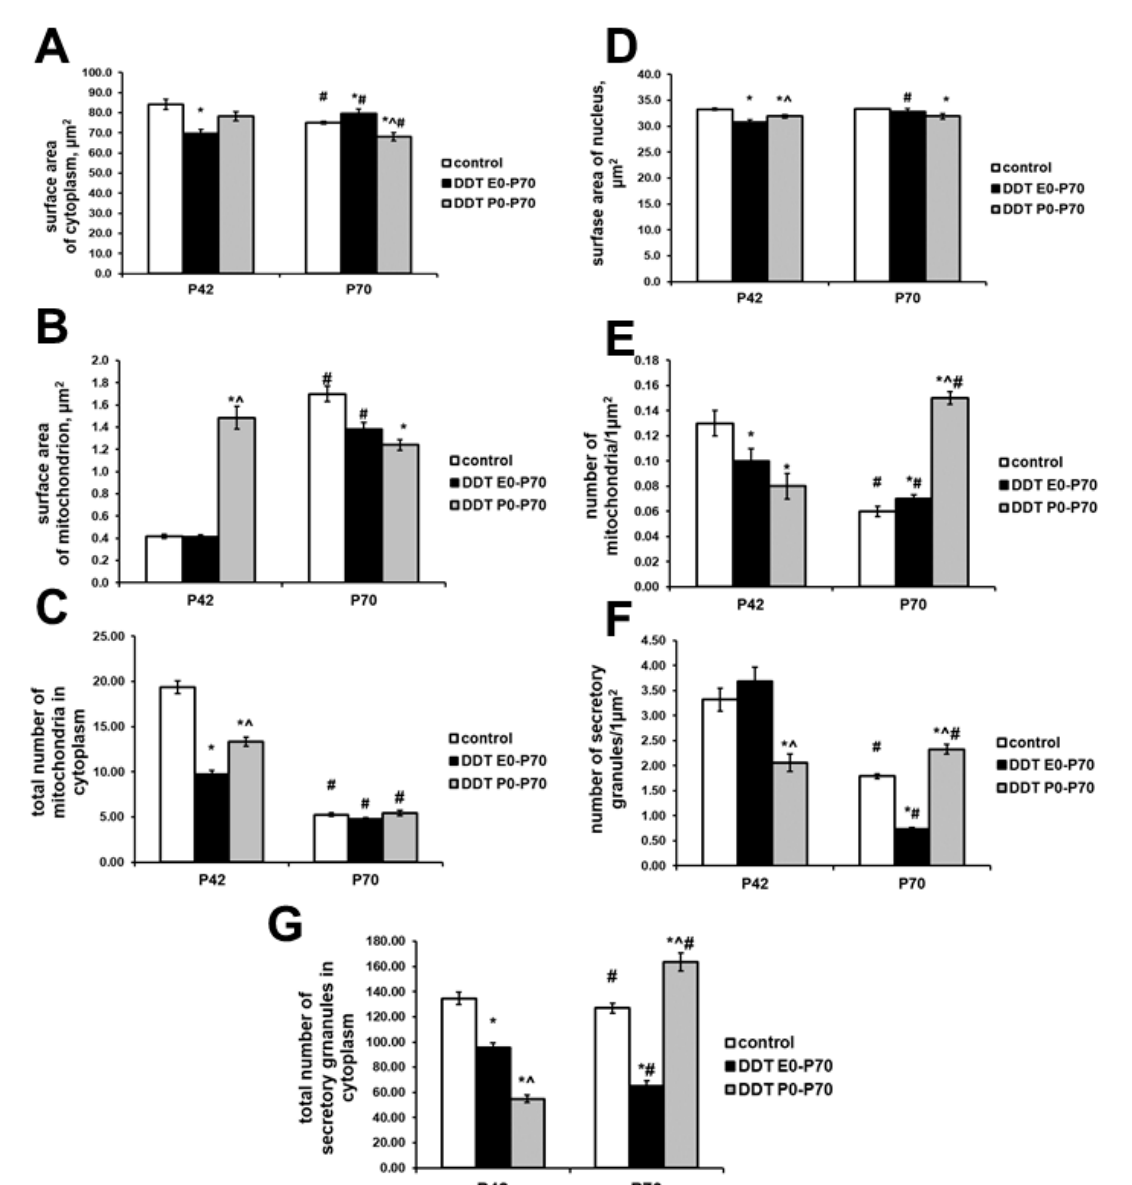
Figure 4. Changes in fine structure of the epinephrine-producing cells after developmental exposure to low doses of o,p’-DDT. Surface area of cytoplasm ( A ), surface area of nucleus ( B ), surface area of mitochondrion ( C ), number of mitochondria per 1 µm 2 of cytoplasm ( D ), total number of mitochondria in cell ( E ), number of secretory granules per 1 µ m 2 of cytoplasm ( F ) total number of mitochondria in cell ( G ). Data are shown as mean ± S.E.M. P, day of postnatal development; p < 0.05 compared to the control (*), compared to the group DDT E0-P70 (ˆ), compared to P42 (#). In postnatally exposed rats, epinephrine-producing cells demonstrated smaller reduc- tion of cytoplasm and nucleus surface area than the previous group (Figure 4A,B). The fine structure of chromaffin cells was distinct from the control and prenatally and postnatally exposed rats. Mitochondria were significantly enlarged, had low dense swollen matrix and disrupted cristae (Figures 3C and 4C). Their number per 1 µ m 2 of cytoplasm was reduced compared to the control (Figure 4D). Total number of mitochondria in cells was also smaller than in the control, but higher than in the prenatally and postnatally exposed rats (Figure 4D,E). Secretory granules were scattered in cytoplasm. They had